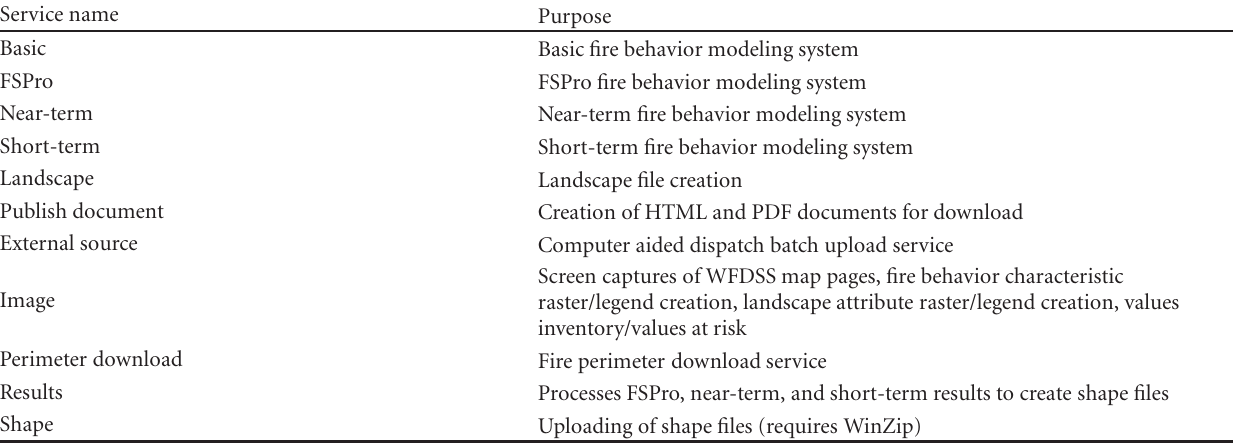
Table 4: List of WFDSS internal services.